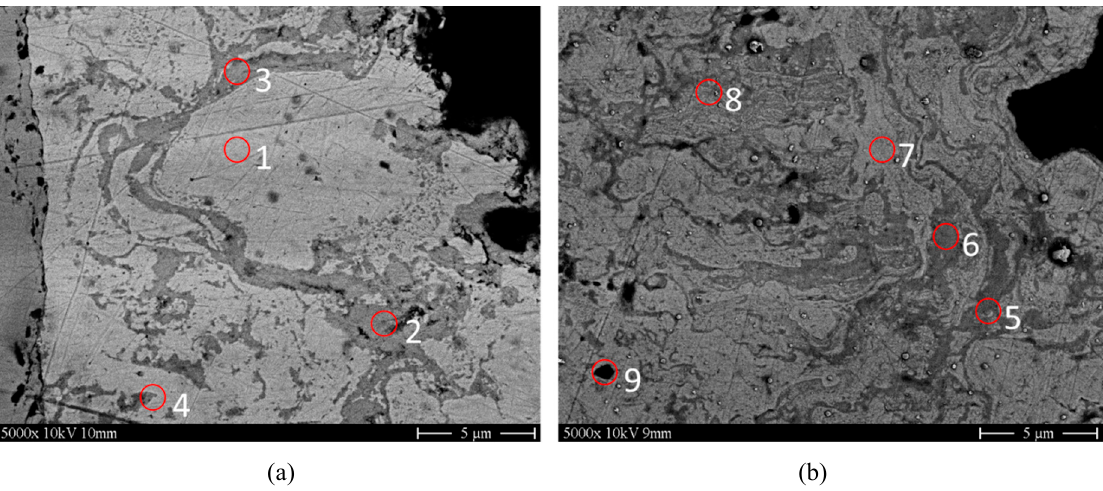
Figure 12. Optical microscope cross-section images of Cu coatings sprayed with a reduced of λ = 0.57 with increasing spray distance (from left to right). Applied spray parameters: λ = 0.57; total gas volume = 190 L/min.